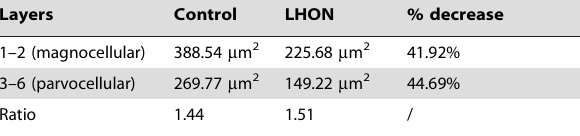
Table 2. Top: neuron soma size by layer type for LHON and control LGN.